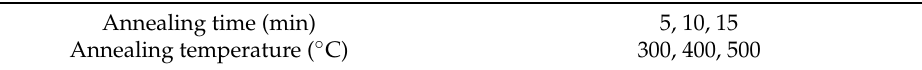
Table 3. RTA annealing parameters of the ZnO thin films.